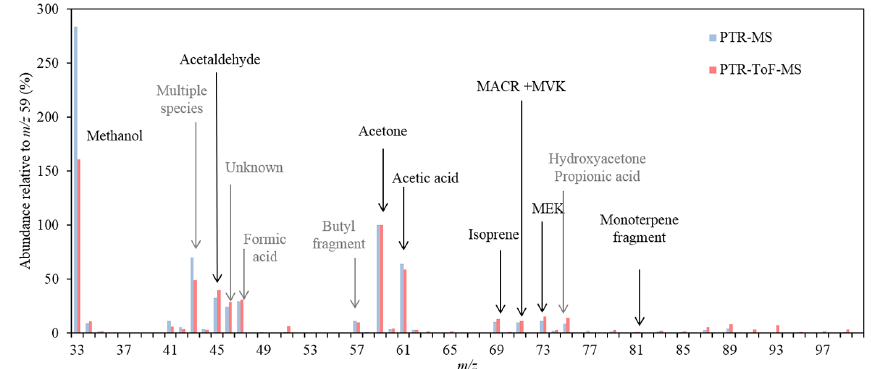
Figure 6. Comparison of PTR-MS (blue) and PTR-ToF-MS (red) mass scans relative to m/z 59 at unit mass resolution averaged between 14 and 24 June. Compounds recorded in flux mode using the PTR-MS are presented in black with compounds tentatively identified in grey.